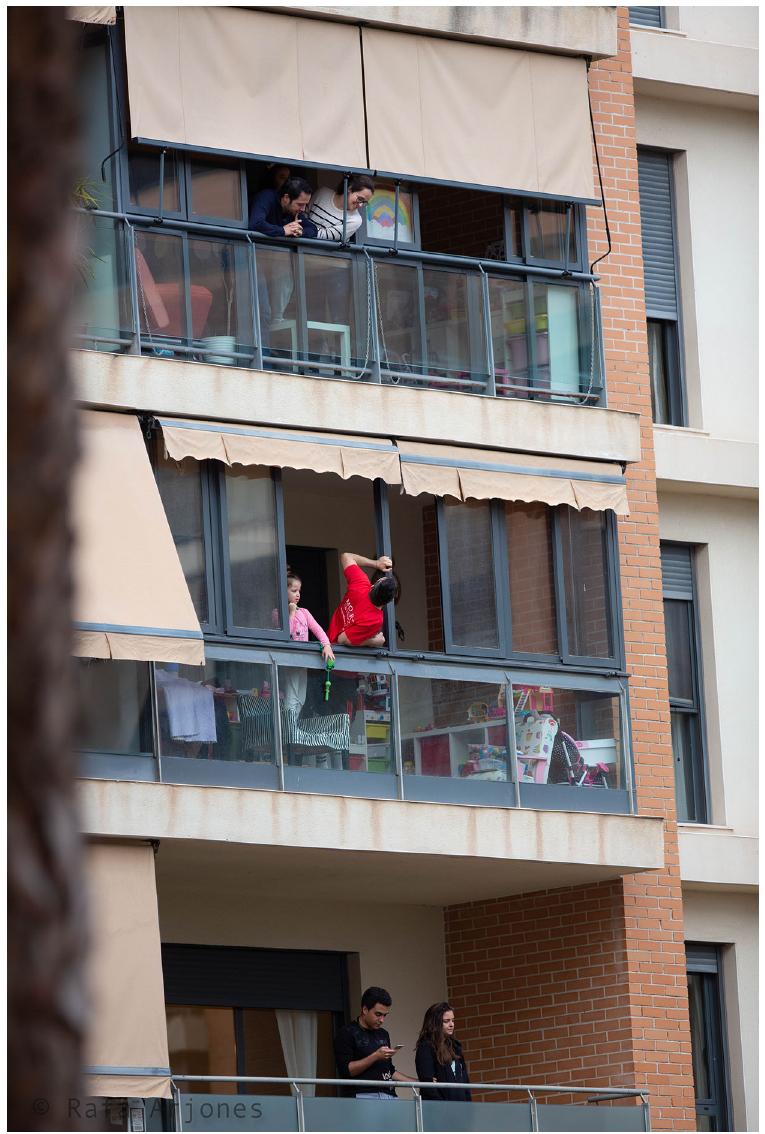
Figure 9. Home confinement increased social relations between neighbours and generated different ways of shaping the communitas. The image shows how people talked from their balconies when they were unable to go out into the street. This figure has been reproduced with kind permission of the